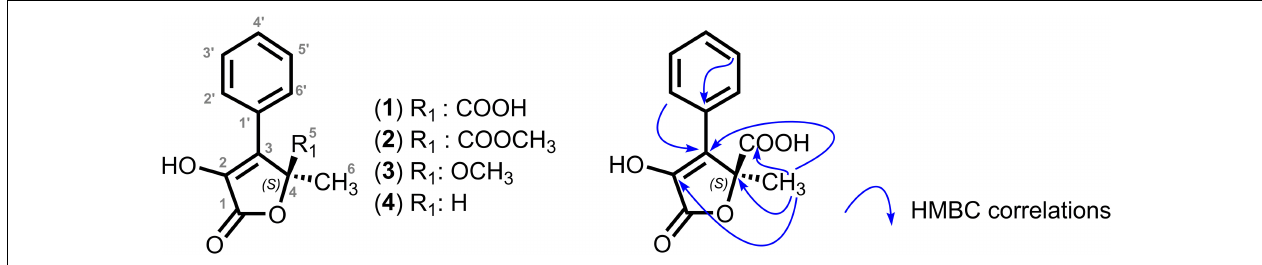
FIGURE 1 | Structures of the dendryphiellones A-D ( 1-4 ) and key HMBC correlations for the dendryphiellone A.